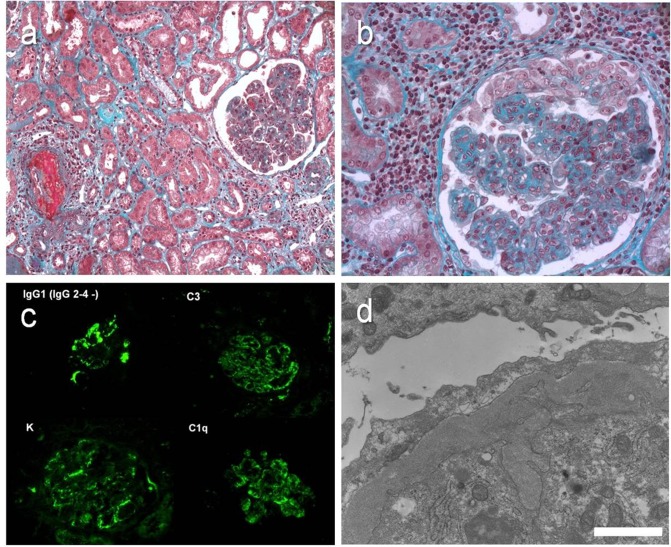
Representative cases of MPGN.(a) Case 10. Light microscopy, Masson trichrome staining. Cryoglobulin-related MPGN. Endocapillary proliferation, fibrinoid necrosis and pseudo-thrombi. Original magnification, X 20. (b) Case 11. Light microscopy, Masson trichrome. Endo- and extracapillary proliferation. Note the severe CLL/SLL monomorphic infiltrate. Original magnification, X 40. (c) Case 11 (IgG kappa type I cryoglobulin). Immunofluorescence microscopy. Endomembranous deposits of IgG1, kappa, C3, C1q. Original magnification, X 20. (d) Case 11. Electron microscopy. Subendothelial granular and fibrillar deposits. Bar = 1200 nm.